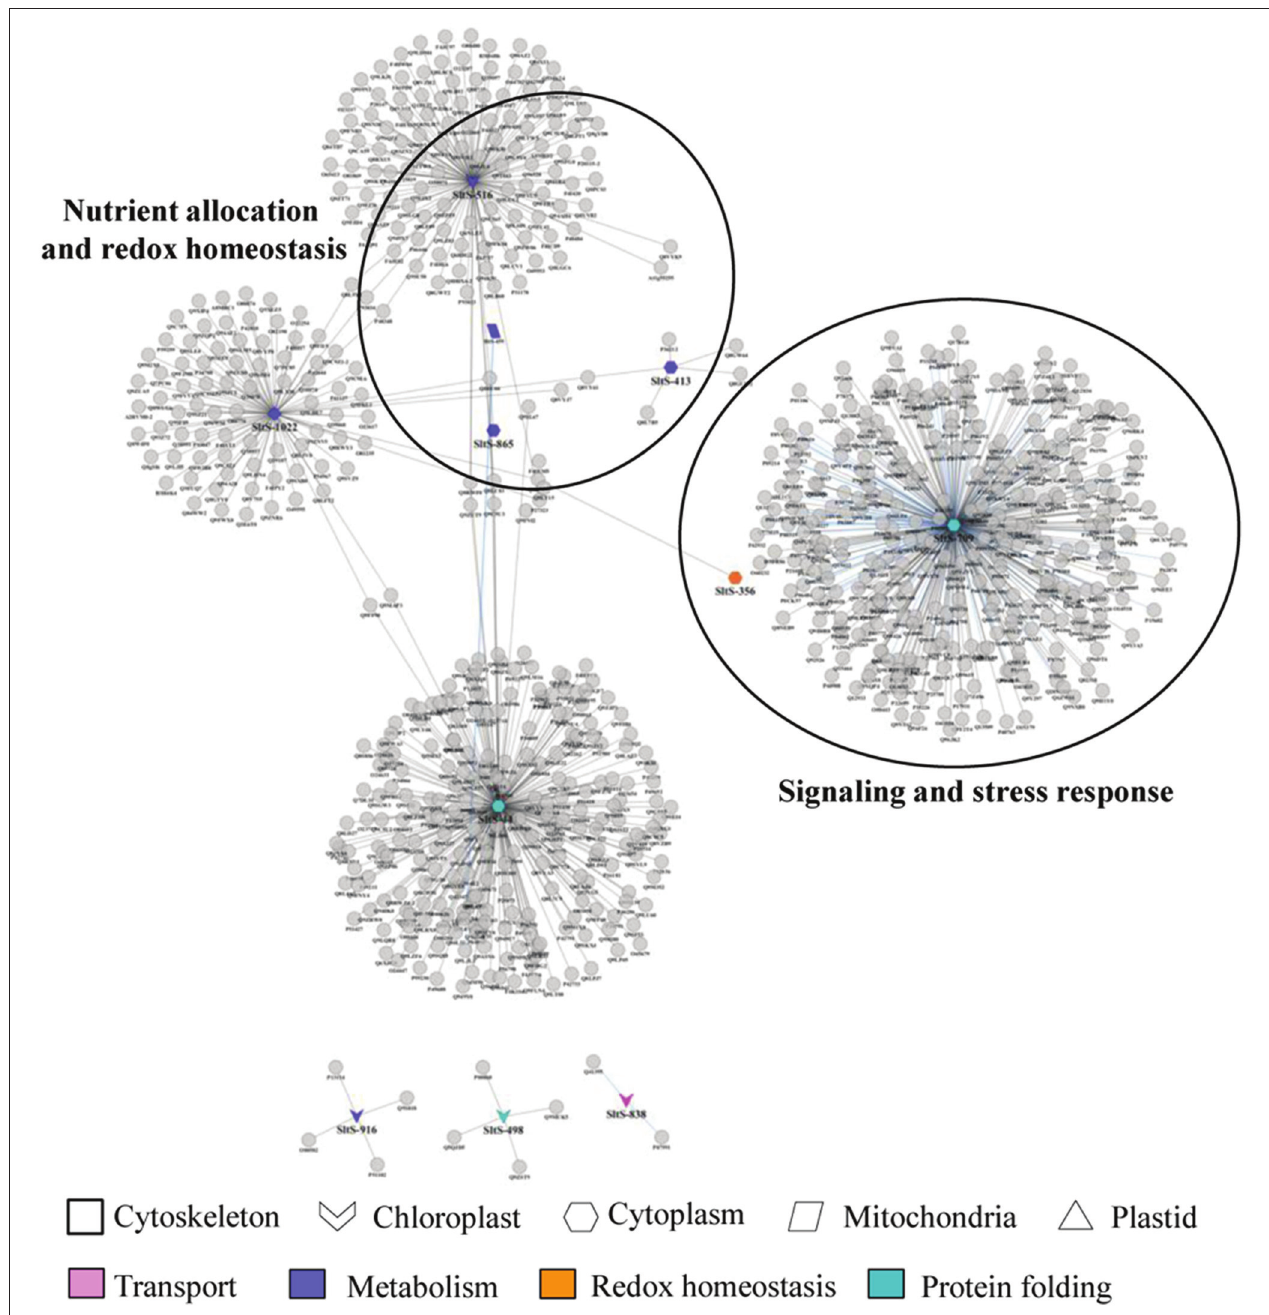
FIGURE 3 | A comprehensive protein-protein interaction network of identified PSRPs. A spoke network of the identified PSRPs were interconnected by querying PPI databases with all identified proteins for experimentally determined interactions as listed in manually curated databases. Node colors represent functional categories while node shape represents subcellular localization of the protein species.